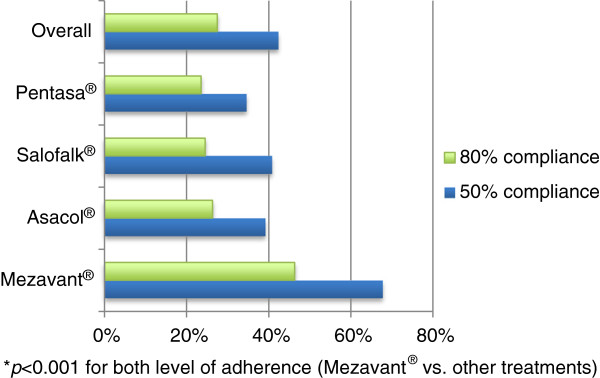
Adherence to 5-ASA Treatments.